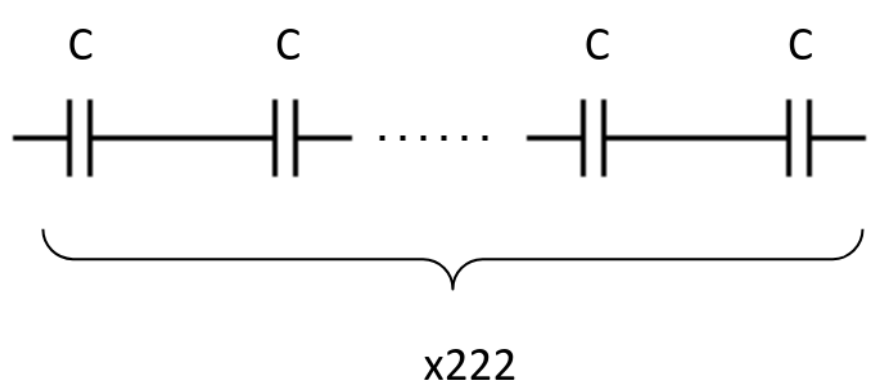
Figure 6. Basic model of the battery.